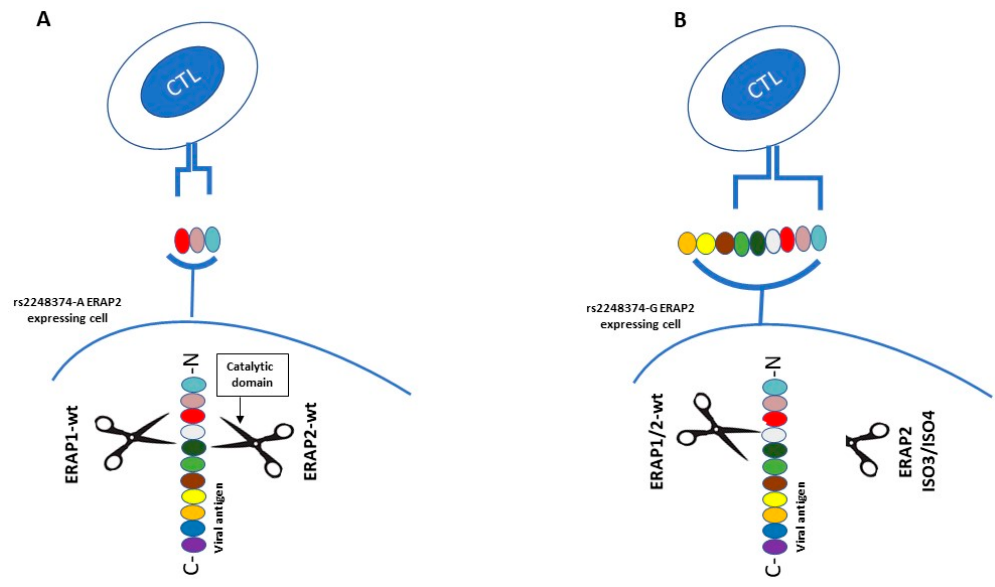
Figure 2. Schematic representation of the mechanism of action displayed by ERAP2 ISO3 and ISO4 in the antigen presentation pathway. ( A ). Following virus infection rs2248374-A ERAP2 expressing cells produce wild type ERAP2 (ERAP2-wt) which can homodimerize or heterodimerize with ERAP1-wt (ERAP2-wt + ERAP2-wt; ERAP1-wt + ERAP2-wt), in order to process viral antigens to be presented on cell surface for recognition by specific cytotoxic T lymphocyte (CTL) clones. ( B ). Following virus infection rs2248374-G ERAP2 expressing cells may transcribe two alternative spliced isoforms: ERAP2-ISO3 and ERAP2-ISO4. This two variants, unlike ERAP2-wt, lack the catalytic domain but can still heterodimerize with both ERAP2-wt and ERAP1-wt. As a result, these unconventional heterodimers (ISO3 + ERAP2-wt; ISO3 + ERAP1-wt; ISO4 + ERAP2-wt; ISO4 + ERAP1-wt) may process viral antigens differently from the canonical ones, generating an alternative antigenic repertoire. This in turn may activate other CTL clones and more broadly a more or less protective response by the immune system.